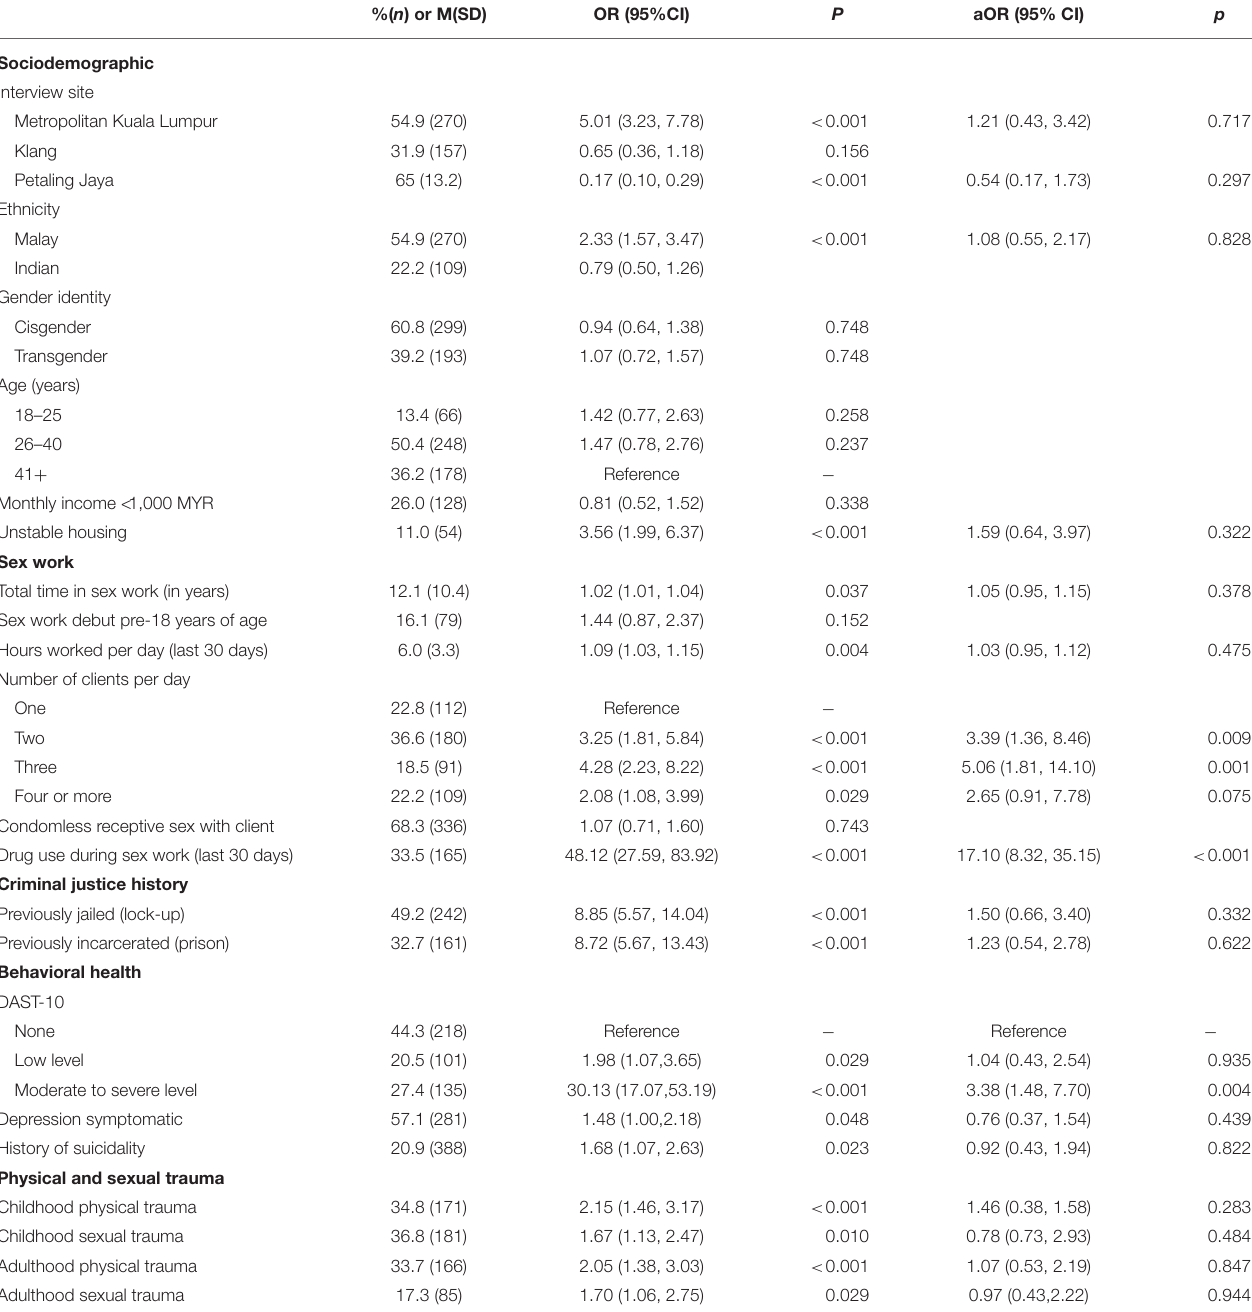
TABLE 1 | Bivariate and multivariable logistic regression for active ATS use ( N = 492). %( n ) or M(SD) OR